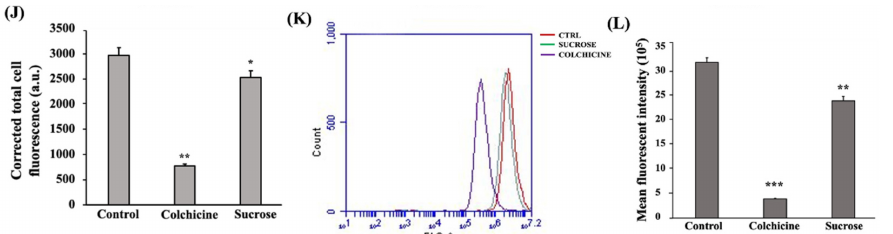
Figure 5. C2C12 myoblasts internalize IC via the pinocytosis pathway. Cell internalization of AO- IC as a function of time analyzed by fluorescence microscopy. ( A ) 0 min, ( B ) 5 min, ( C ) 30 min, ( D ) 120 min, and ( E ) 180 min. ( F ) FACS analysis on cellular uptake of AO-IC. ( G ) CTCF measured upon the cell internalization of AO-IC with respect to time and ( H ) mean fluorescent intensity measured. ( I ) Fluorescent microscopic images of C2C12 myoblast cells treated with or without colchicine and hyperosmotic sucrose, followed by AO-IC incubation for 2 h. ( J ) CTCF measured upon AO-IC internalization after endocytosis inhibitor treatment. ( K ) FACS analysis and ( L ) mean fluorescent intensity measurement post cellular internalization of AO-IC after endocytosis inhibitor treatment. The study was repeated three times, and the results were shown as mean ± SD; n = 3. *, ** and *** show a significant difference at p < 0.05, p < 0.01, and p < 0.001, respectively, compared to the control (Two-tailed t